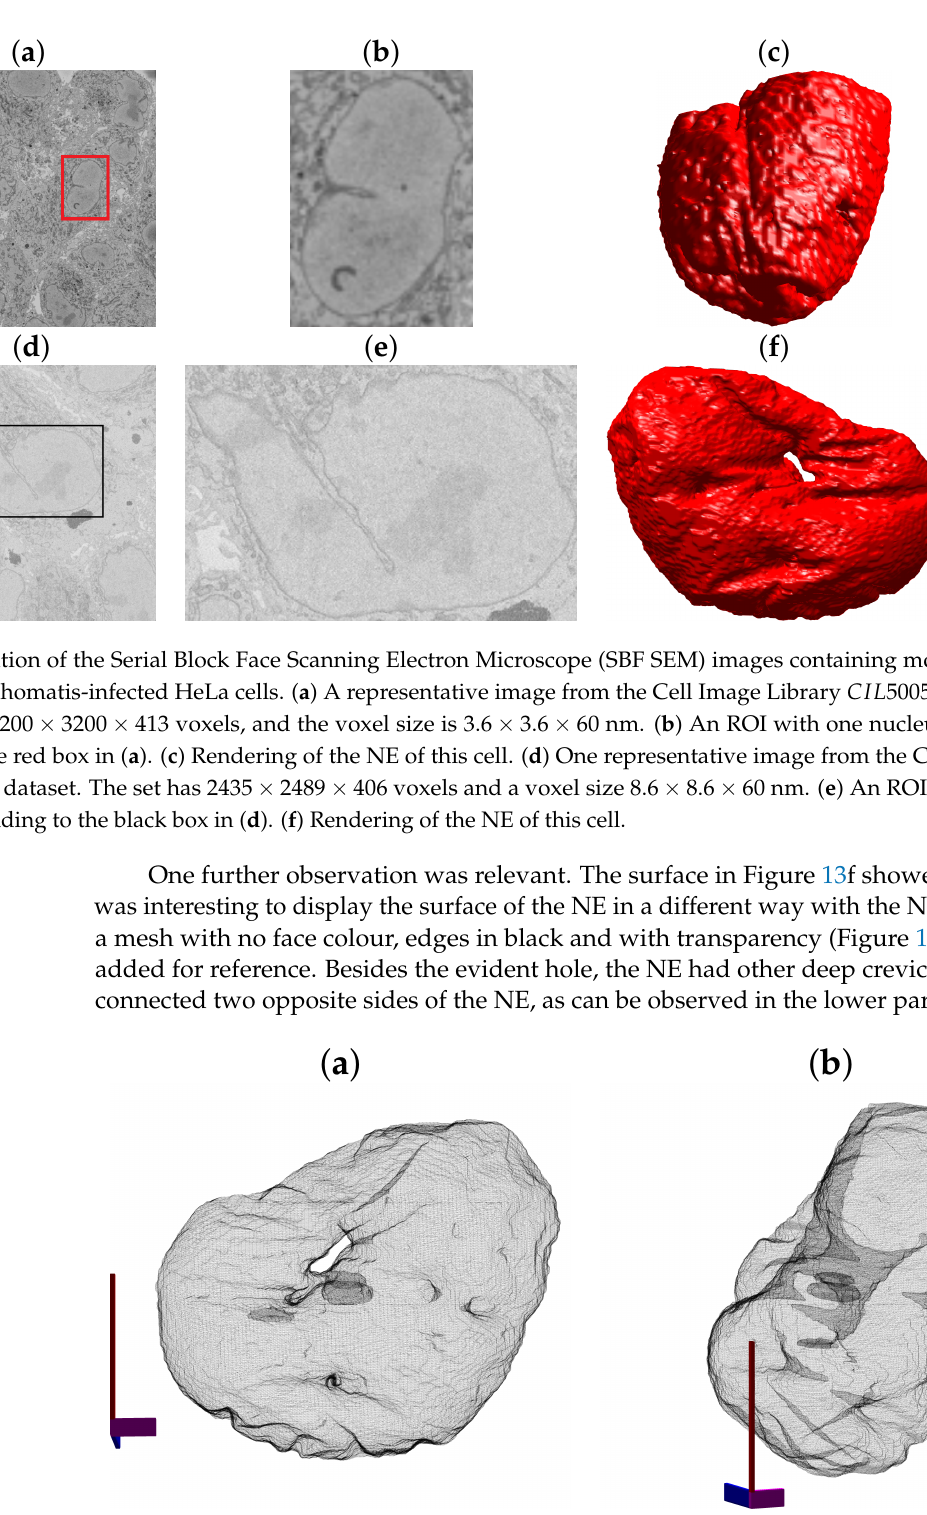
Figure 14. Illustration of the nuclear envelope from the dataset CIL50051. The surface is displayed as a mesh with transparency to show the hole of the nuclear envelope ( a ) and the crevices that go deep inside the nucleus. Notice in ( b ) how these invaginations nearly connect separate sides of the